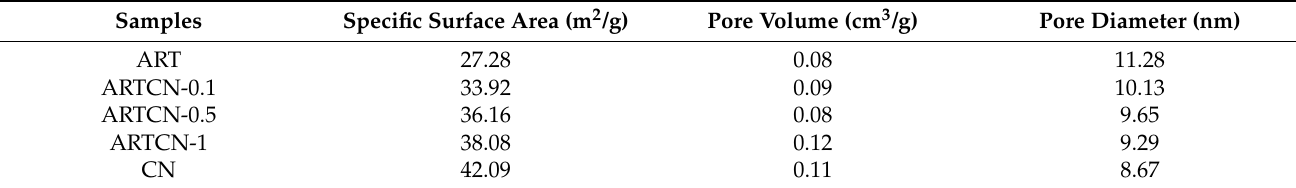
Figure 4. N 2 adsorption–desorption curve ( a ) and pore size distribution ( b ) of the samples. Table 2. Structural parameters of the samples.